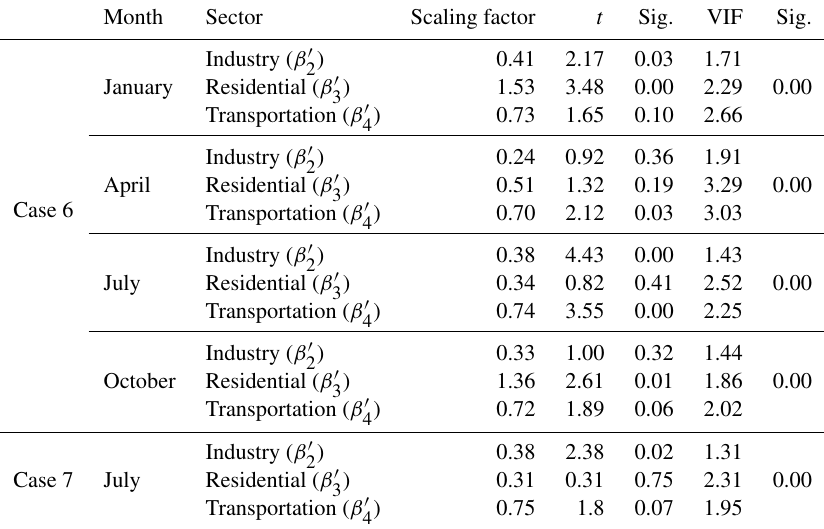
Table 5. The scaling factors and statistical indicators from the multiple regression model in Cases 6 and 7.